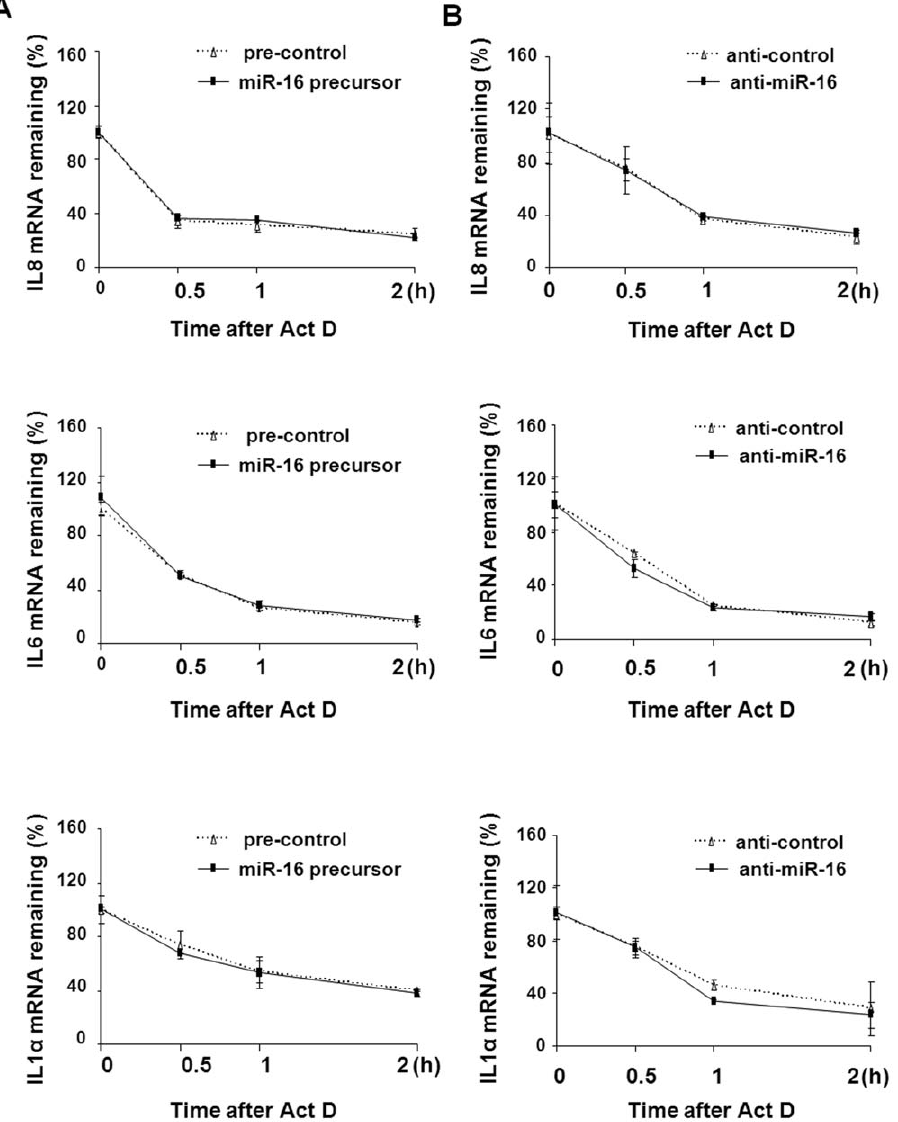
Figure 3. Functional manipulation of miR-16 does not affect the stability of IL-6, IL-8, and IL-1 a mRNAs. (A) Effects of the miR-16 precursor on the stability of IL-6, IL-8, and IL-1 a mRNAs in cells following LPS stimulation. H69 cells were transfected with pre-control or miR-16 precursor (30 nM) for 24 h, followed by exposure to LPS for 2 h. Act D was then added to the cultures, and cells were collected for real-time PCR analysis. The stability of IL-6, IL-8, and IL-1 a mRNAs was calculated and presented as the relative amount of mRNA in cells before Act D treatment. Data represent the average of three independent experiments. (B) Effects of anti-miR-16 on the stability of IL-6, IL-8, and IL-1 a mRNAs in cells following LPS stimulation. H69 cells were transfected with anti-control or anti-miR-16 (30 nM) for 24 h, followed by exposure to LPS for 2 h. Act D was then added and RNA stability was measured as described above.